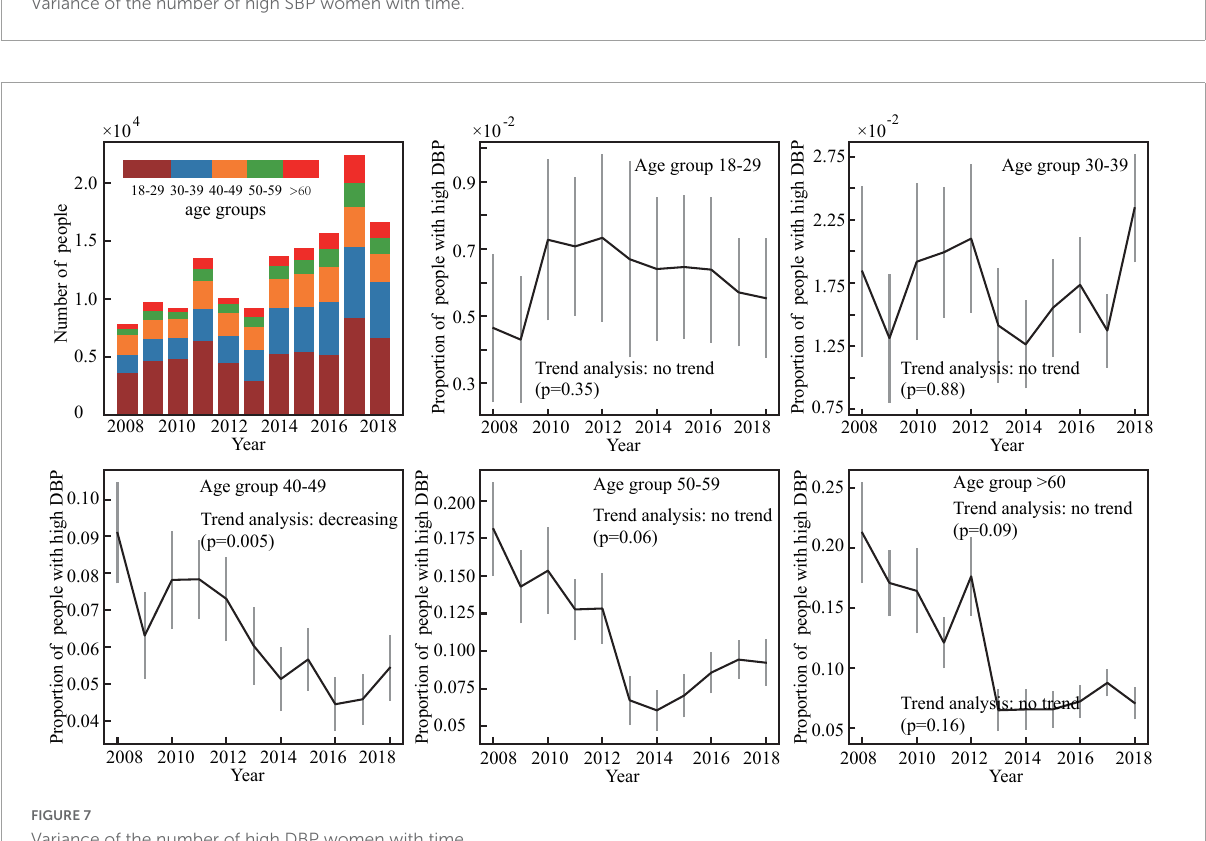
FIGURE6 Variance of the number of high SBP women with time.